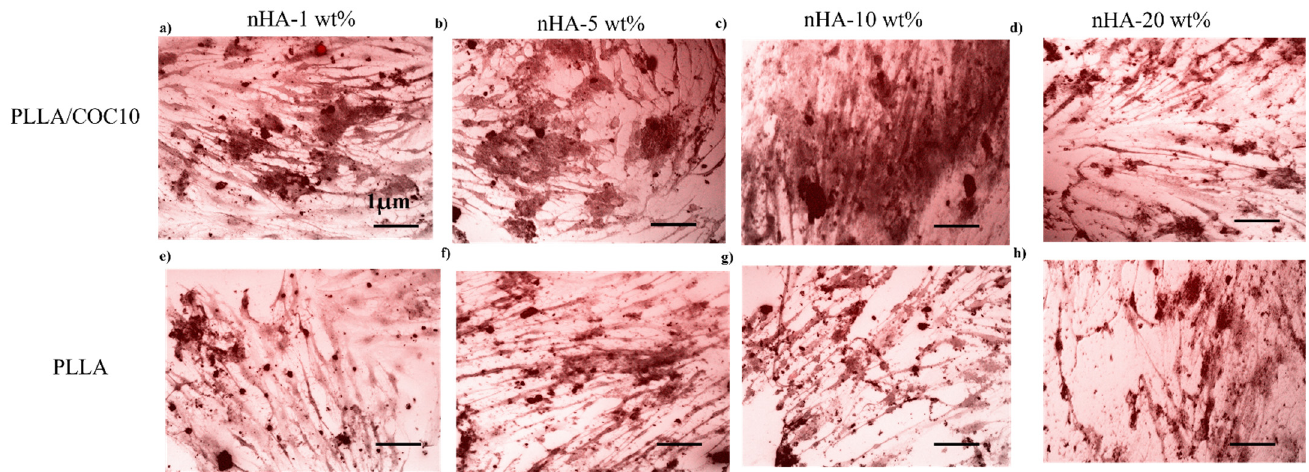
Figure 12. Alizarin red S staining was used to analyze the mineralization of MC3T3-E1 cells for PLLA/COC10-nHA ( a − d ) and for PLLA-nHA ( e–f ). MC3T3-E1 cells were grown for 14 days, then stained with alizarin red S to identify mineralized nodules after 14 days. Scale bar: 1 μ m in all the images. Nanocomposites had nHA in 1 wt%, 5 wt%, 10 wt%, and 20 wt%. After three different experiments, the data is represented.